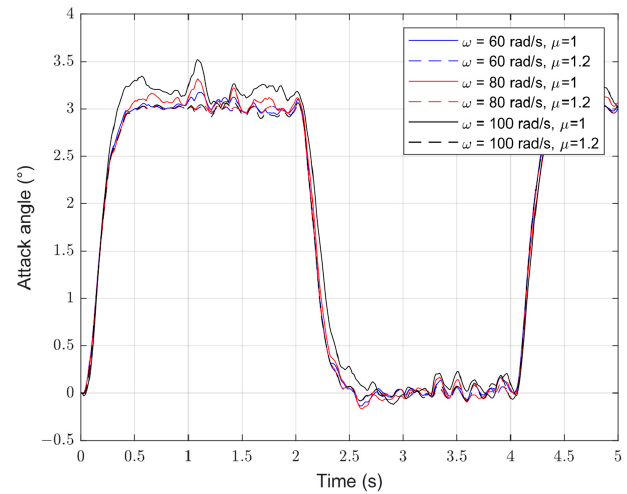
Figure 8. Response of Angle of Attack with Measurement Noise.